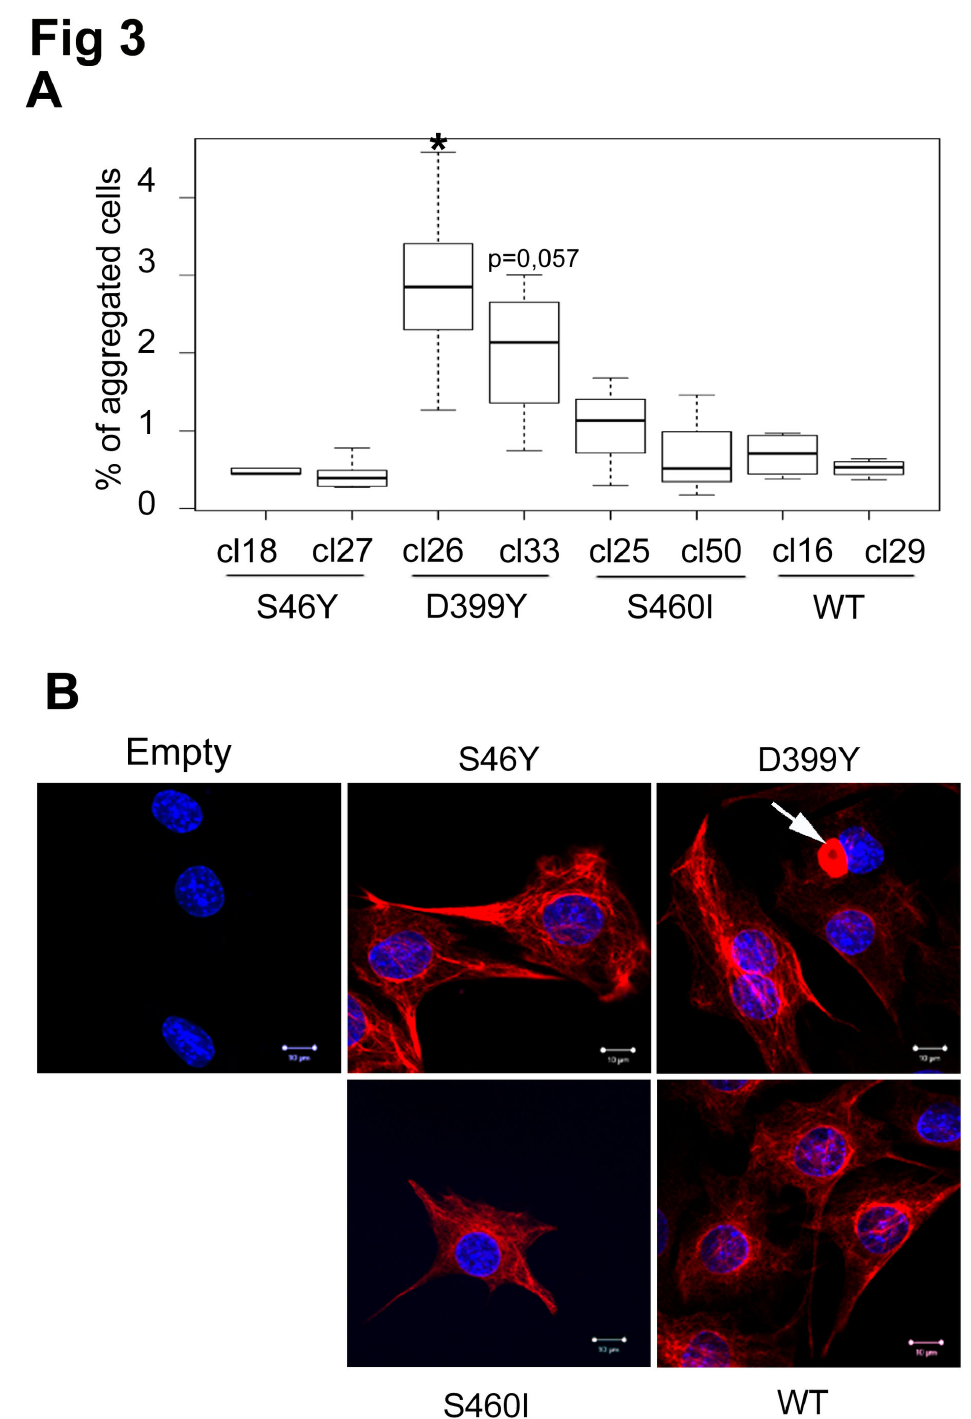
Figure 3. Basal desmin aggregation rates in stably-expressing cells. ( A ) Quantification in box plot of cells containing aggregates for different desmin WT or mutated Tet-On constructs, 48 h after desmin expression induction. Cell counting was performed on three independent experiments (over 100 cells each). Significant differences are indicated with asterisk (p<0.05) calculated with non-parametric test. “Cl-Number” represents the name of the selected clone for each desmin mutation. ( B ) Immunostaining: in red, Myc-desmin; in blue, Hoechst staining. Only DesD399Y-expressing cells form large aggregates throughout the cytoplasm and near nucleus (white arrow). White bar =10µm. doi: 10.1371/journal.pone.0076361.g003 PLOS ONE |